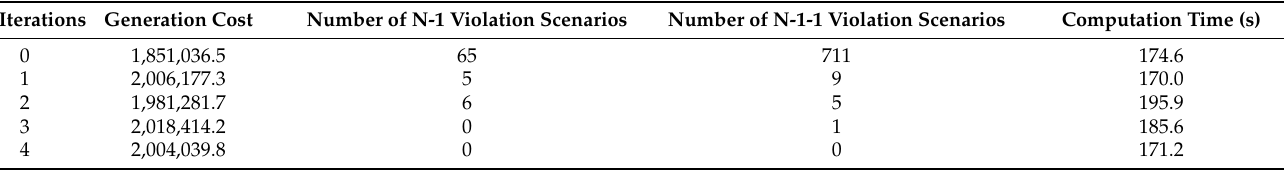
Table 5. Results of the iterative contingency filtering process of the SCAPD model tested on the Polish 2383-bus system.